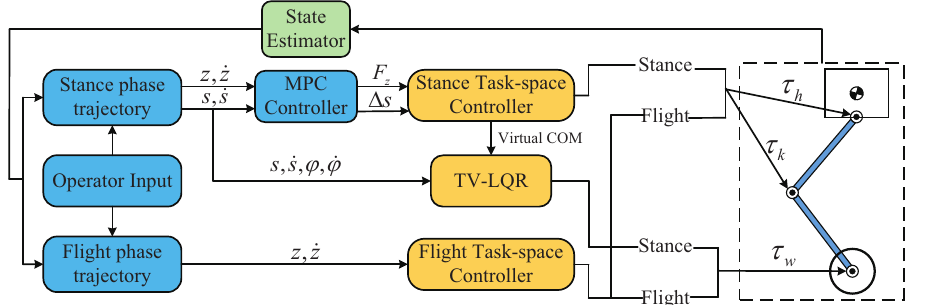
Figure 4. Overview of the control architecture. Blocks shaded blue run at 100 Hz, blocks shaded green run at 500 Hz, and blocks shaded gold run at 1000